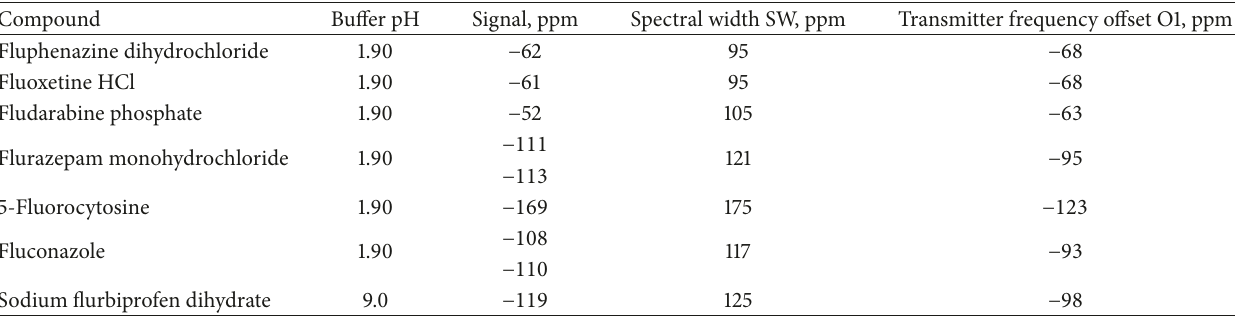
Table 2: Spectra widths and buffer pH of buffer soluble